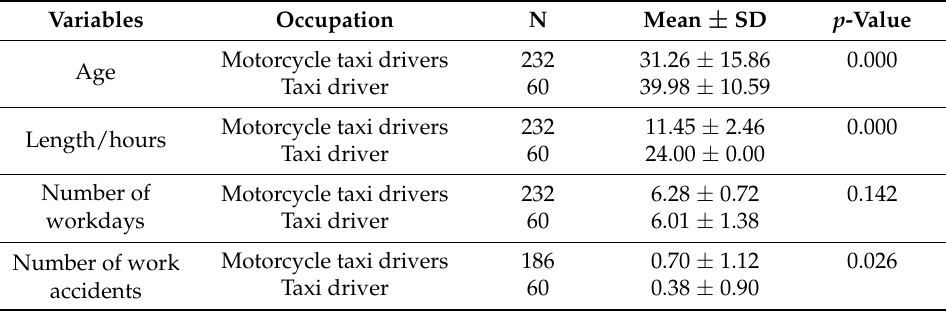
Table 1. Comparisons of age, length of workday in hours, number of workdays per week, and number of work accidents between taxi and motorcycle taxi